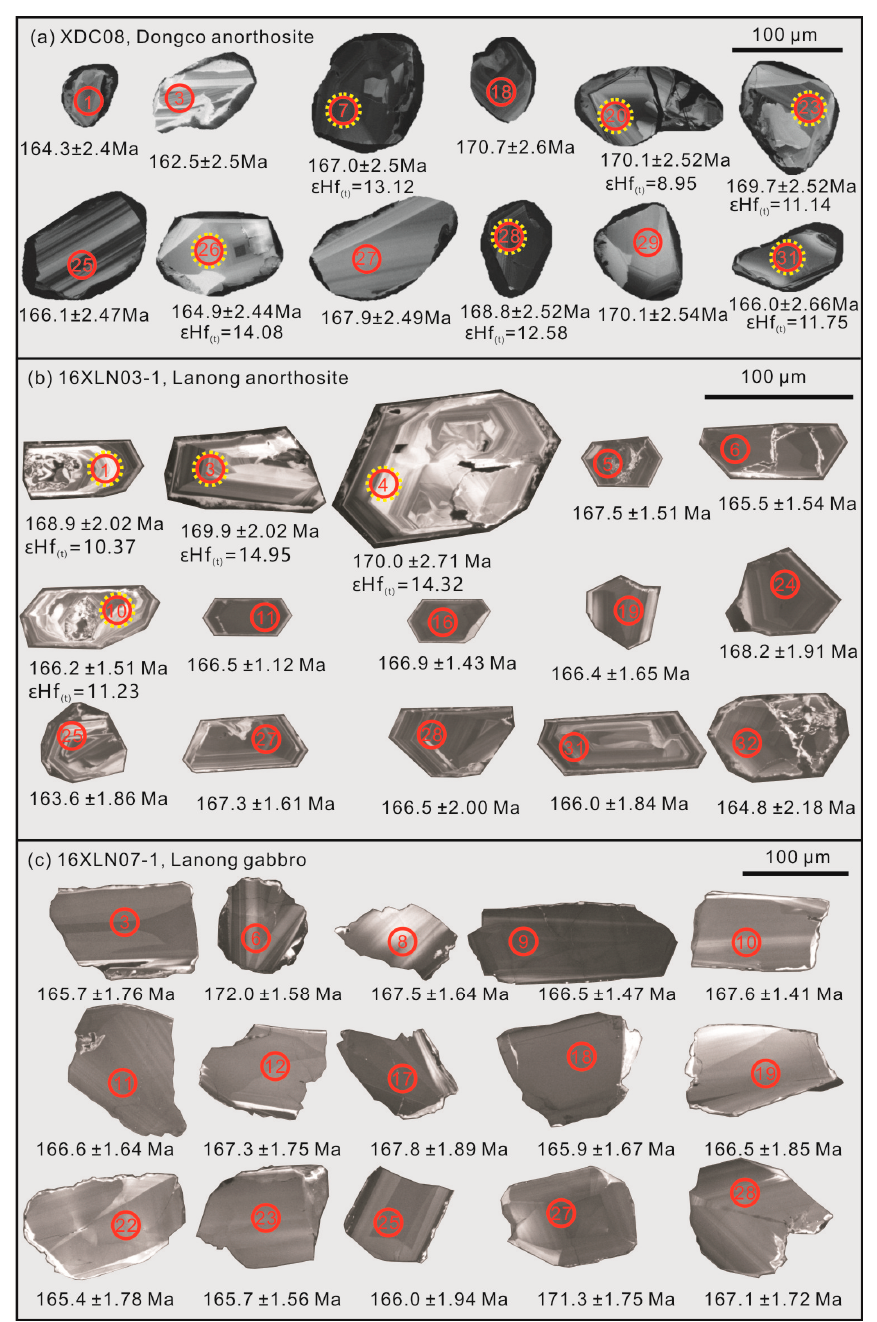
Figure 6. Cathodoluminescence images showing the internal micro-textures of the zircon grains we